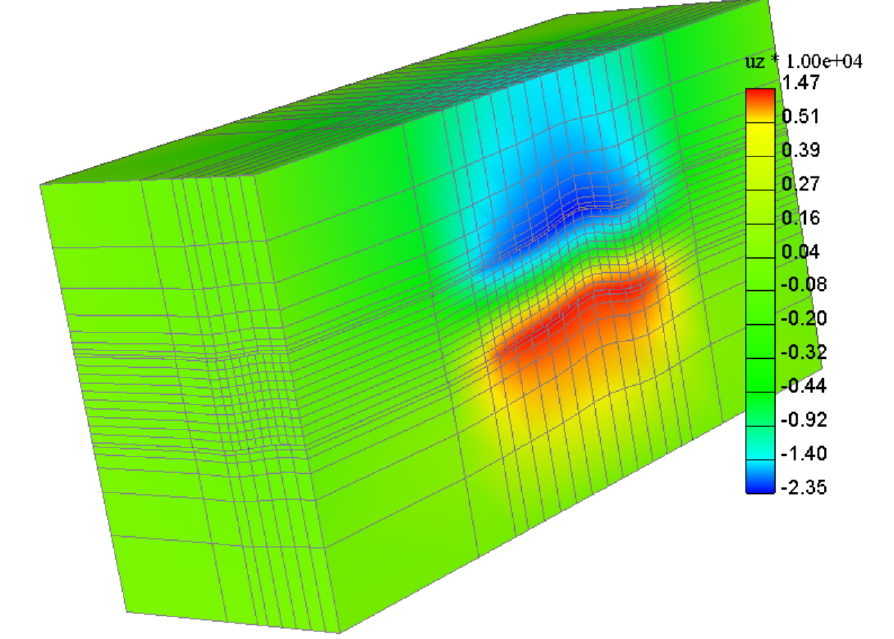
Figure 26. MFEM solution for Example 3 in Section